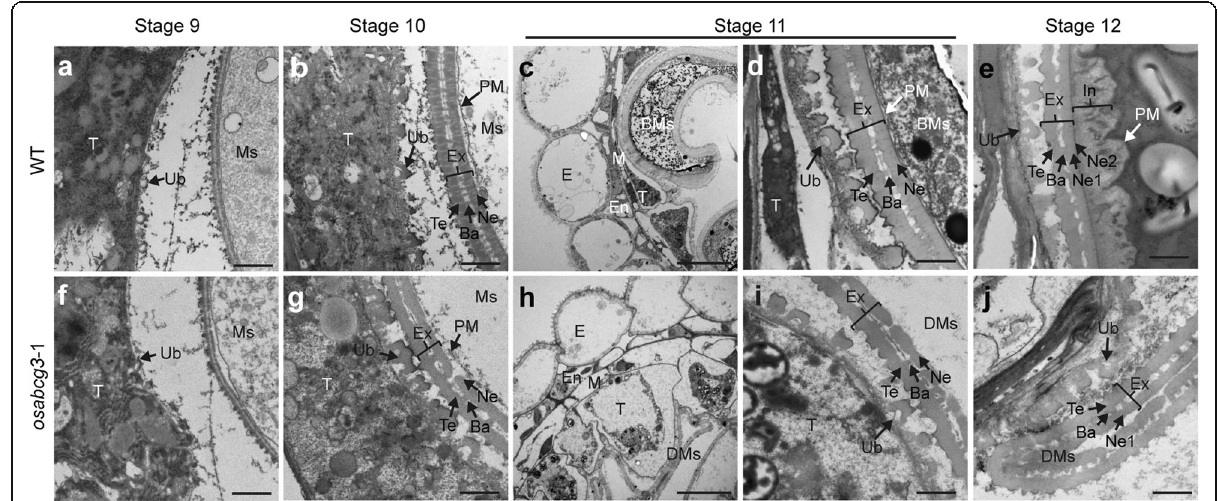
Fig. 5 TEM analysis of the anther sections in WT and osabcg3 – 1 from stages 9 to 12. WT anthers are showed in a-e, and osabcg3 – 1 anthers are showed in f-j . Ba, bacula; BMs, binuclear microspores; DMs, degenerated microspore; E, epidermis; En, endothecium; Ex, exine; In, intine; M, middle layer; Ms., microspores; Ne, nexine; Ne1, nexine I; Ne2, nexine II; PM, plasma membrane; T, tapetal layer; Te, tectum; Ub, Ubisch body. Scale bars = 1 μ m ( a-b , d-g , i , j ); 10 μ m ( c, h